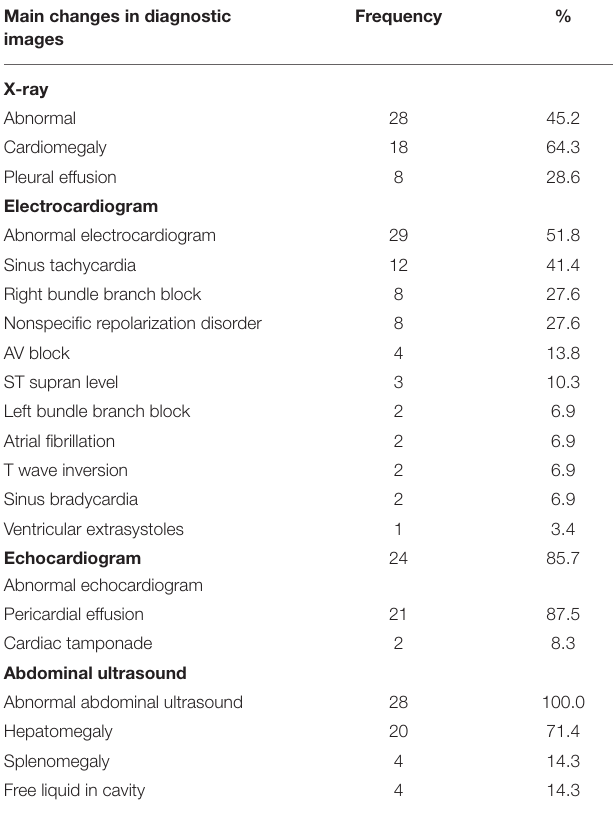
TABLE 2 | Main findings reported in diagnostic images, Acute CD, Casanare